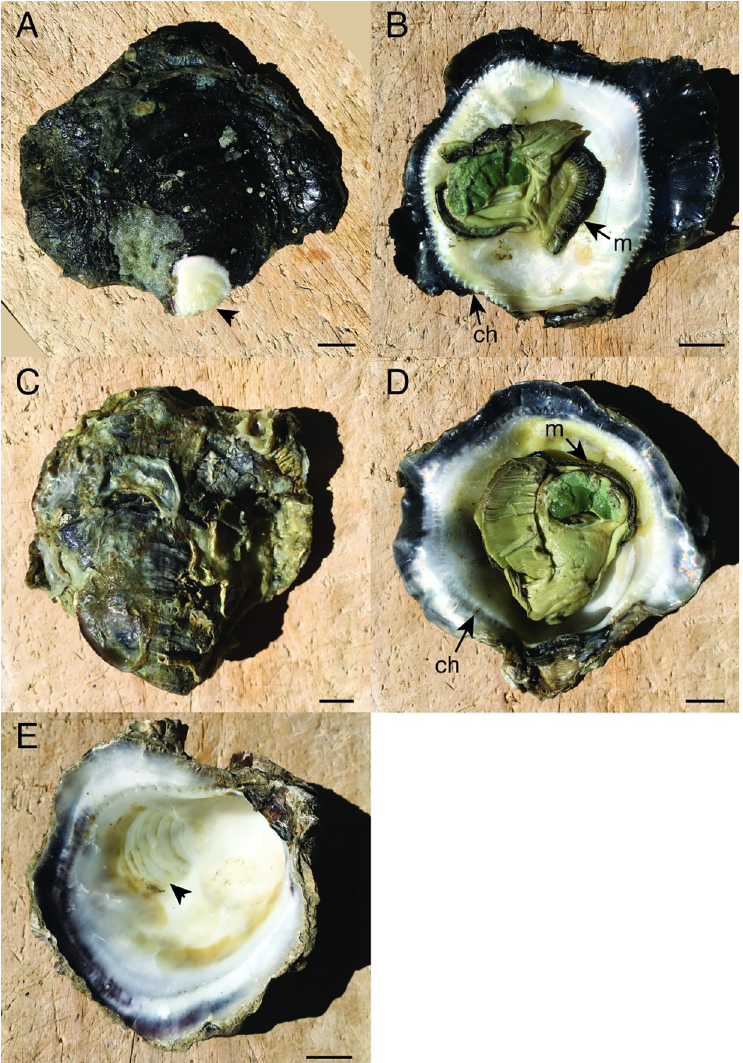
Fig 1. Morphology of the black-lip oyster. The sample has been stored in ethanol, causing some shift in colour within the internal soft tissues. A. Upper surface of the right valve, showing intense dark pigmentation. The outer shell layer has been chipped away at the umbo (arrowhead). B. Inner surface of the right valve. The dark outer shell margin is sharply separated from the white internal surface by large, obvious chomata (ch). The mantle edge is darkly pigmented (m). C. Outer surface of the deeply-cupped left valve. D. Inner surface of the left valve, showing a dark outer shell margin and obvious chomata, and dark pigmentation in the mantle E. Inner surface of the left valve of a second specimen, with soft tissues removed to display the adductor scar (arrowhead). Scale bar = 10mm.